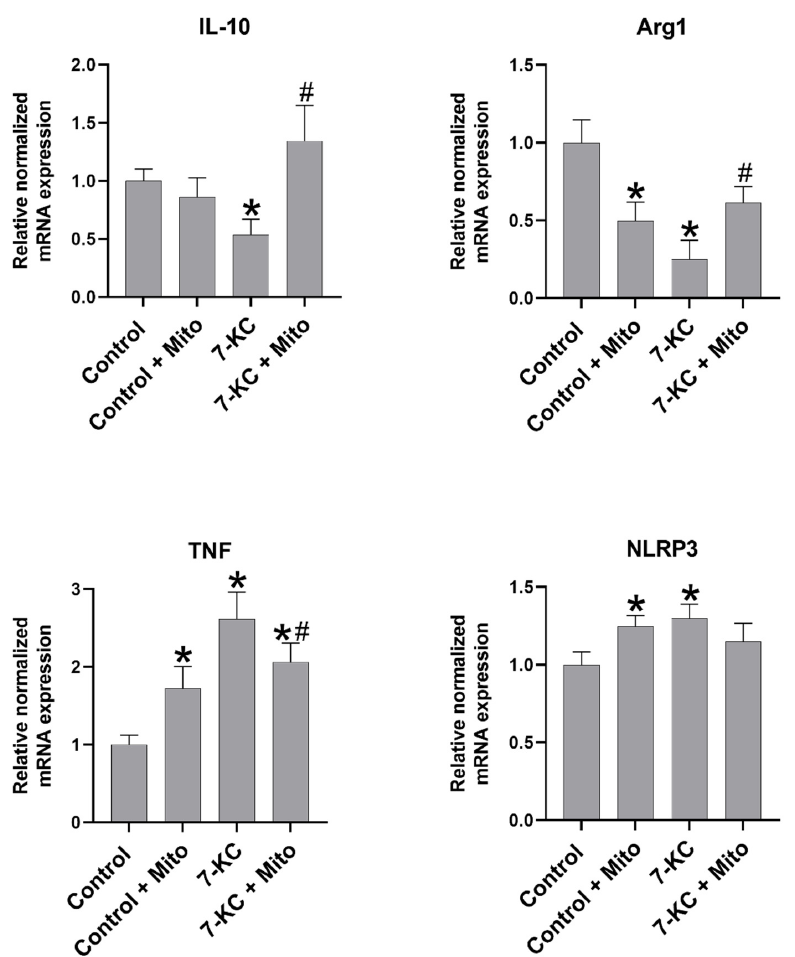
Figure 3. Healthy mitochondrial transfer between macrophages is involved in macrophage phenotype switch. mRNA expression determined by qPCR of TNF, arginine, NLRP3, and IL10. Data are represented as means ± SEM of six independent experiments with n = 3 each. p ≤ 0.05 * vs. control, # vs. 7-KC-loaded cells.